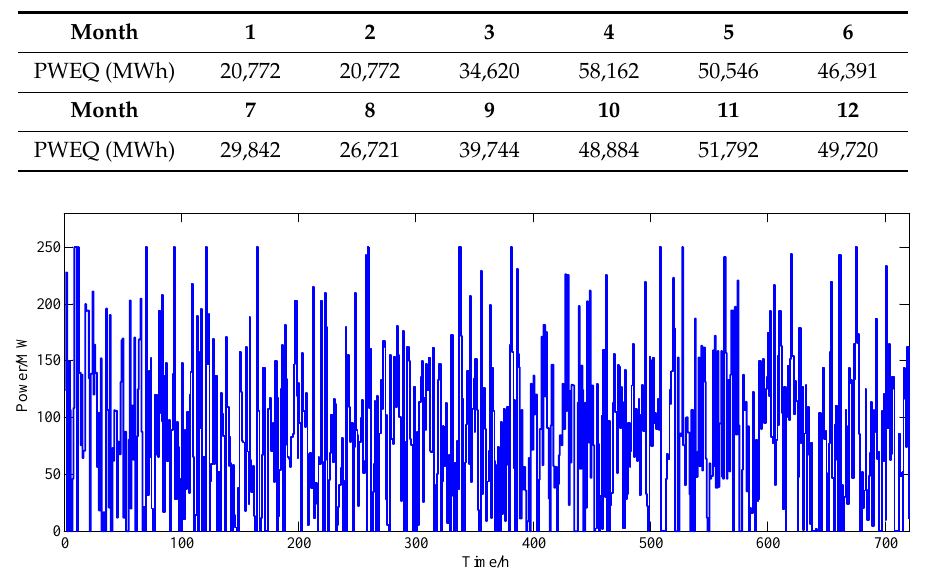
Figure 4. The actual wind power generation curve.